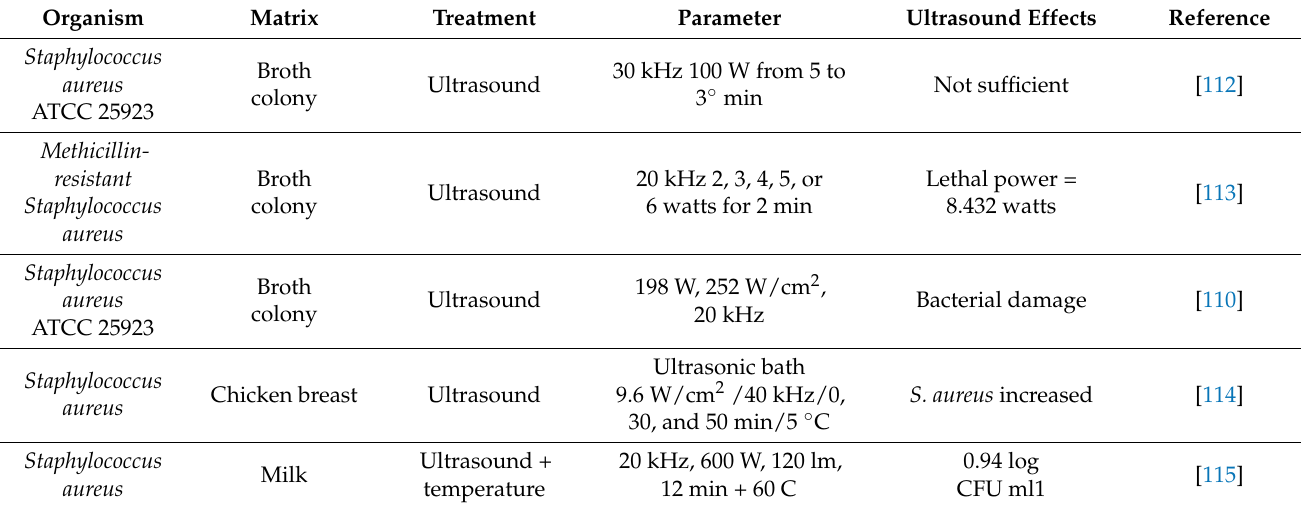
Table 5. Ultrasound effects as single or combined non-thermal technology: Staphylococcus aureus